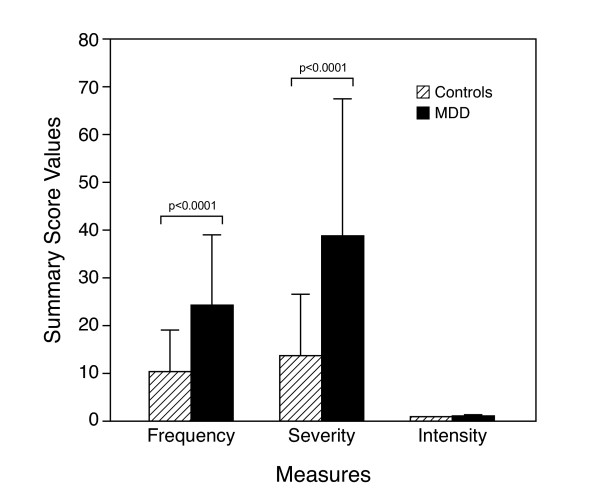
Daily Hassles Scale.